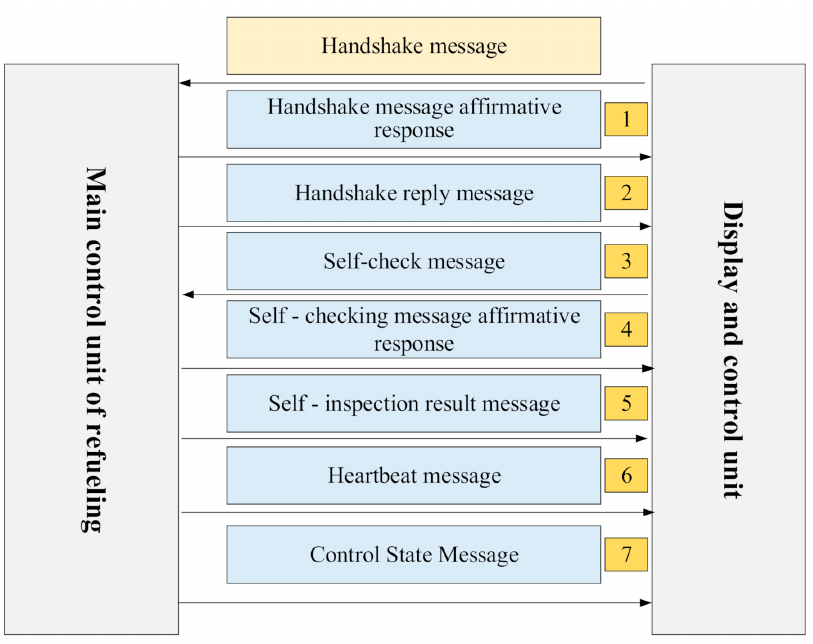
Figure 11. The communication flow between MCU and DCU.